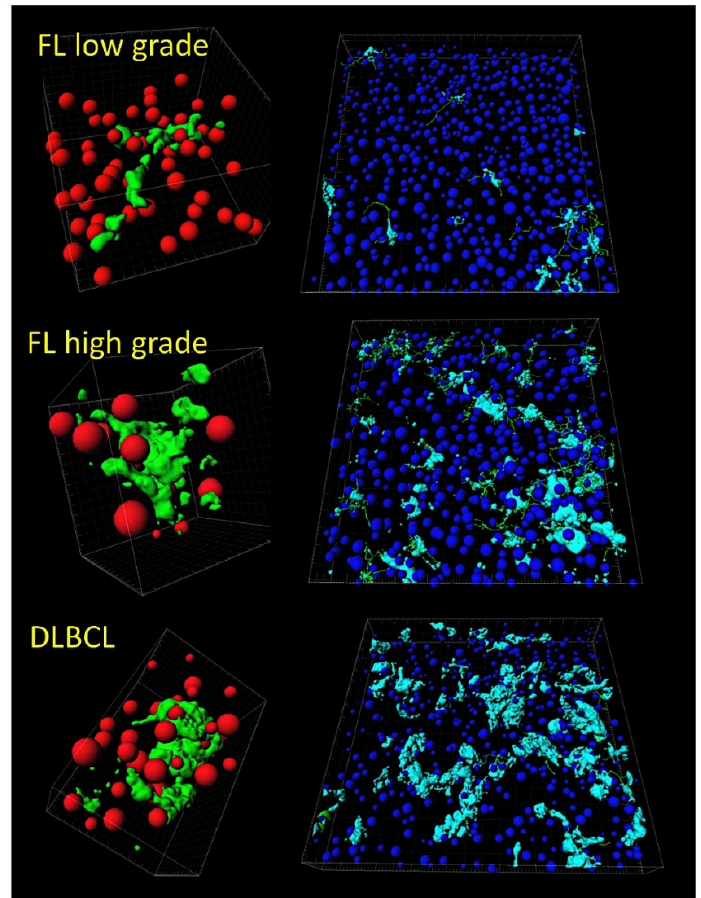
Figure 7. Tridimensional analysis of tumor-associated macrophages (TAMs) in follicular lymphoma. The analysis of M2-like TAMs in follicular lymphoma showed that the progression from low grade to high grade, and the transformation to diffuse large B-cell lymphoma, were associated with increased numbers of TAMs, which created a physical network-like structure. This result points out that TAMs may contribute to the disease pathogenesis. In this figure, the macrophages are highlighted in pale blue (right) and green (left). B and T lymphocytes are in dark blue and red. The images were obtained using a LSM 700 laser scanning confocal microscope from Carl Zeiss (Carl-Zeiss-Strasse 22, 73447 Oberkochen, Germany), and Imaris software (version 8.4, Oxford Instruments, Belfast, United Kingdom). FL, follicular lymphoma; DLBCL, diffuse large B-cell lym- phoma.